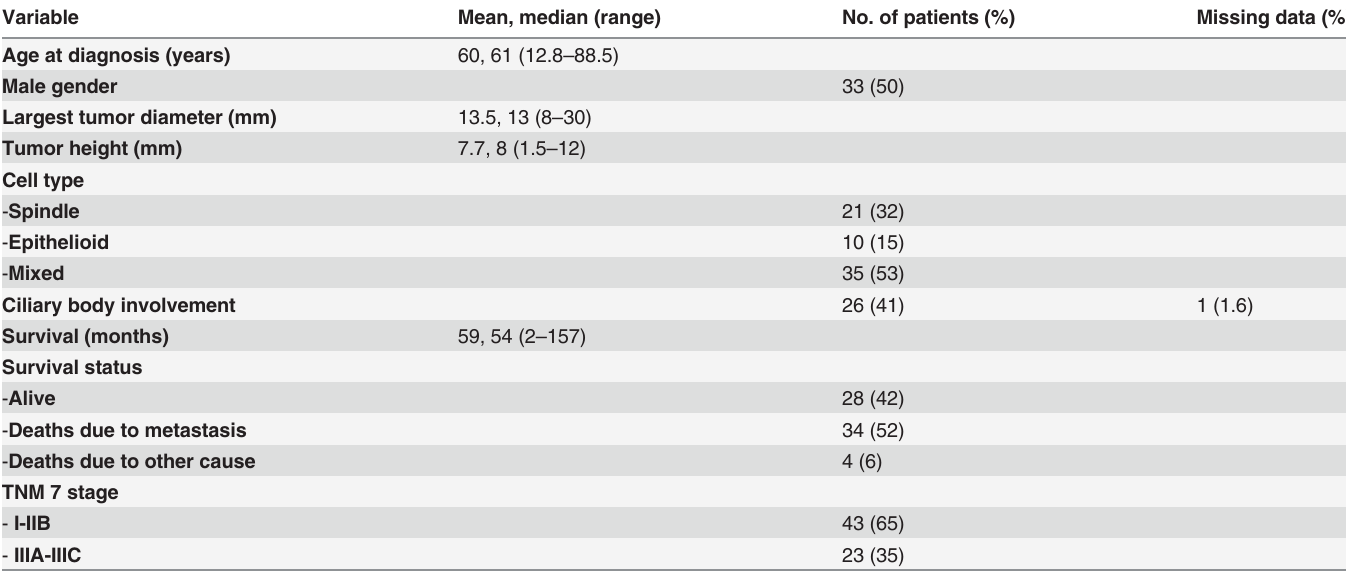
Table 1. Tumour characteristics and survival data of 66 uveal melanoma